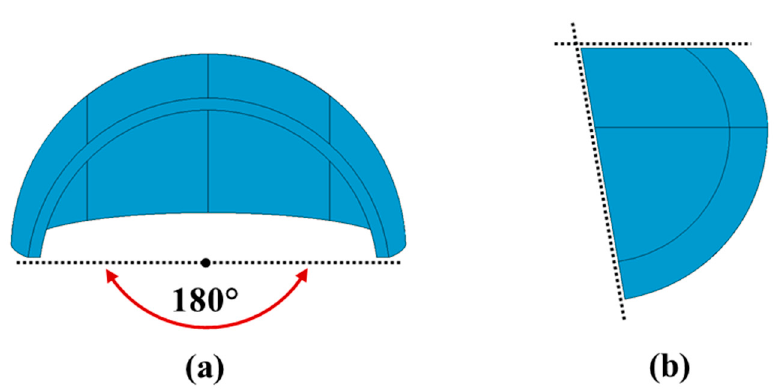
Figure 1. Visual representation of the restrictions imposed upon the blade in ( a ) plan view and ( b ) side elevation.